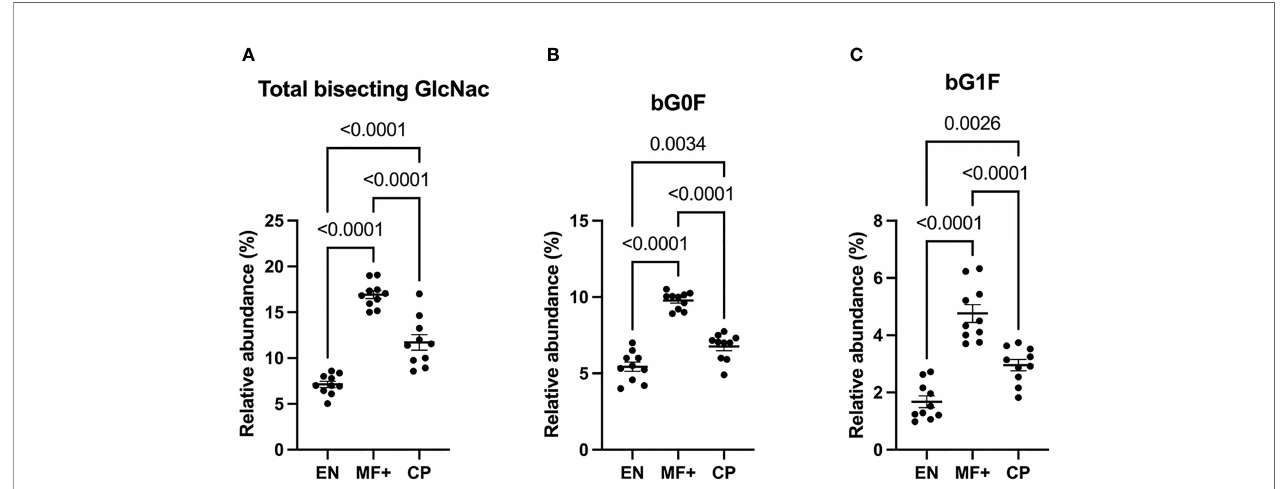
FIGURE 8 | Higher levels of N-linked GlcNac are associated with asymptomatic infection during LF. Graphs represent the relative abundance of IgG bound glycan structures with bisecting GlcNac, total (A) , or in combination with fucose (B) or a galactose and fucose molecule (C) . Dots represent individual donors. Bars represent means ± SEM. Statistical analyses were performed using the Kruskal – Wallis nonparametric test with Dunn ’ s multiple comparison post-test. Signi fi cance is accepted when P <